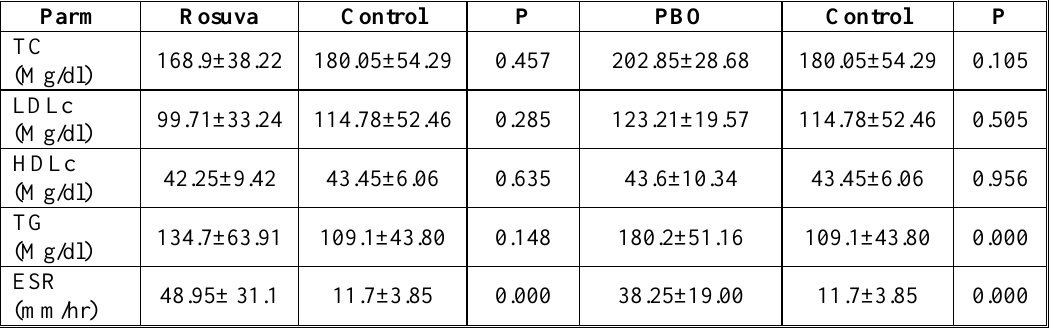
Table (2) Comparison in baseline laboratory data of rheumatoid arthritis patients with control subjects